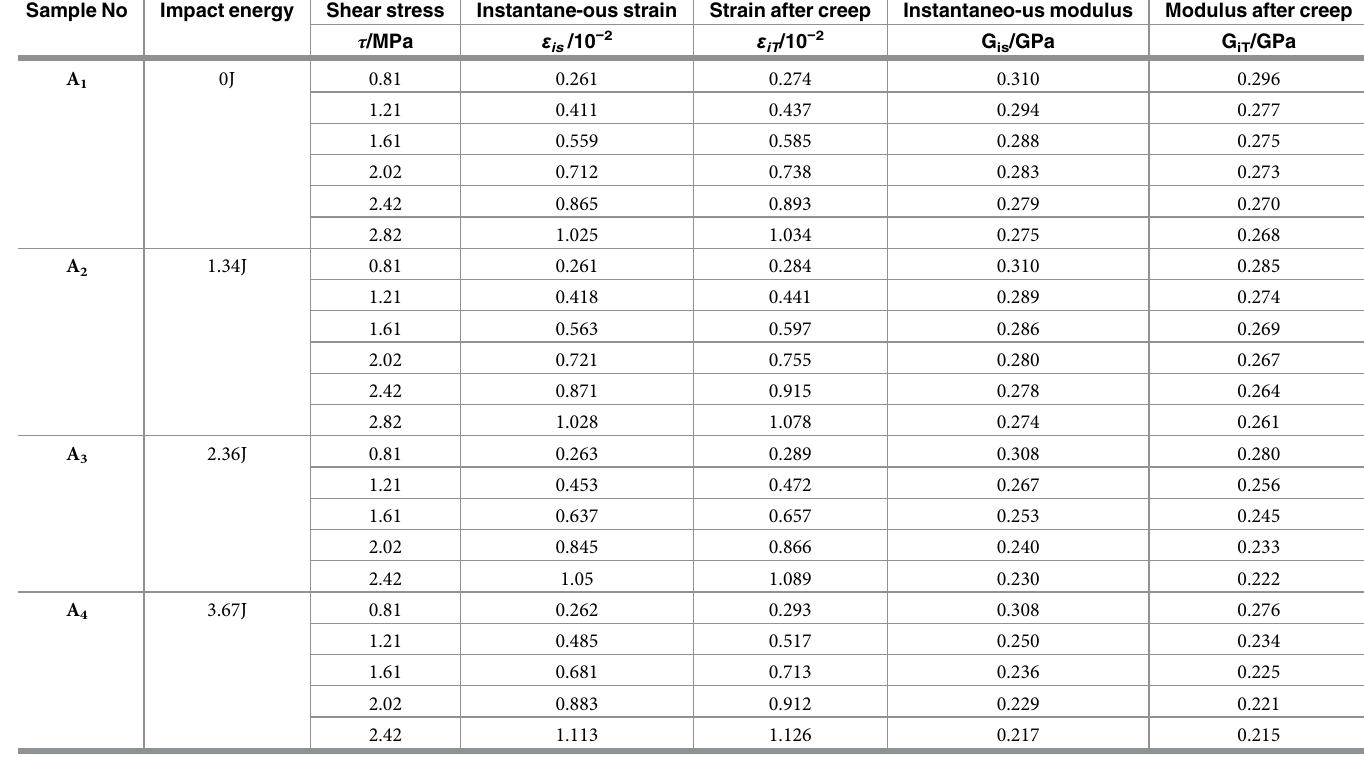
Table 2. Calculation results for mud shale strain and secant shear modulus under different shear load levels. Sample No Impact energy Shear stress Instantane-ous strain Strain after creep Instantaneo-us